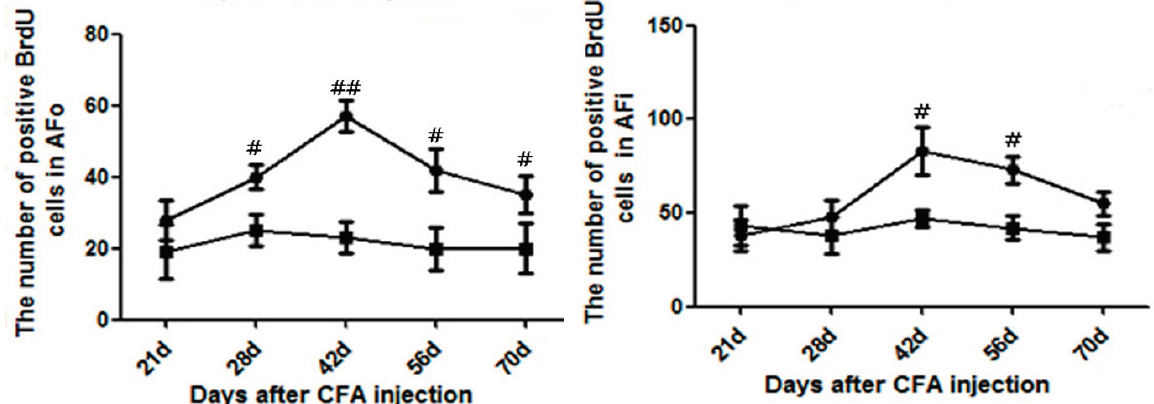
Figure 3. Comparisons of the 5-bromo-2-deoxyuridine (BrdU)-positive cells in four different areas between the CFA exercise group and CFA spontaneous recovery